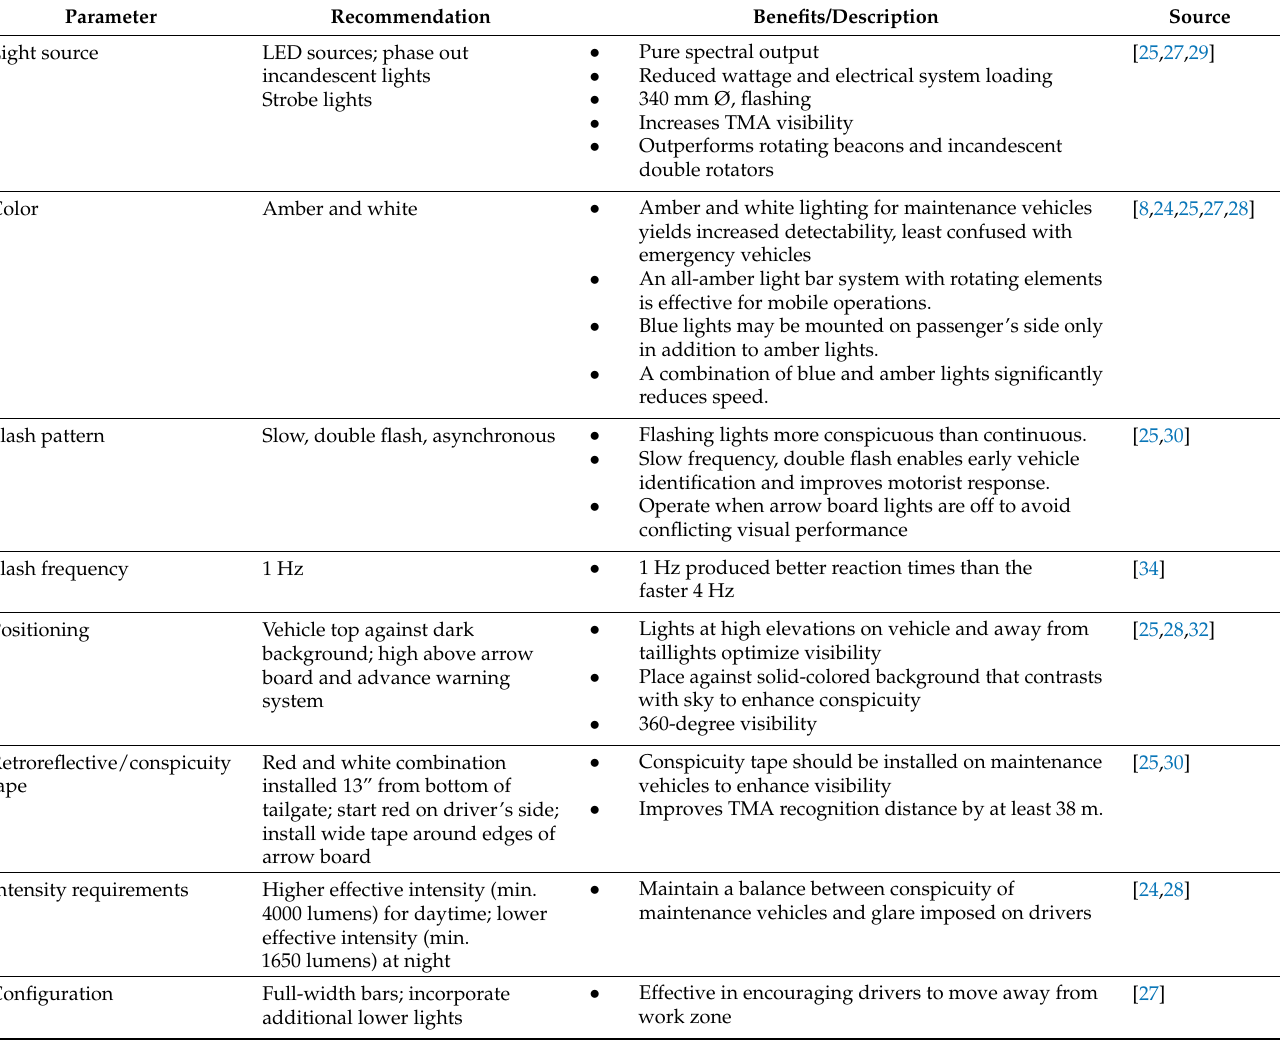
Table 8. Recommendations for warning lights on truck-mounted attenuators from various